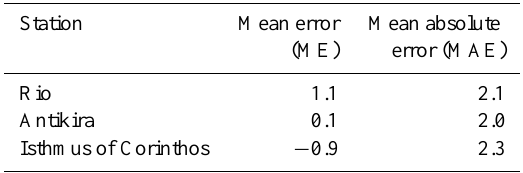
Table 2. Mean error and mean absolute error of the wind speed at Rio, Antikira, and Isthmus of Corinthos